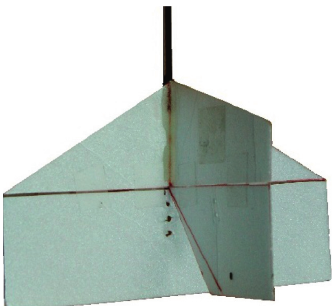
Figure 14: A T-shaped tail fin.